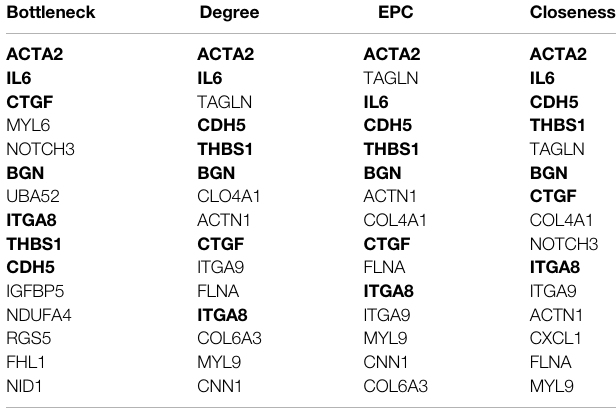
TABLE 2 | The Top 15 Hub Genes Rank in cytoHubba. Bottleneck